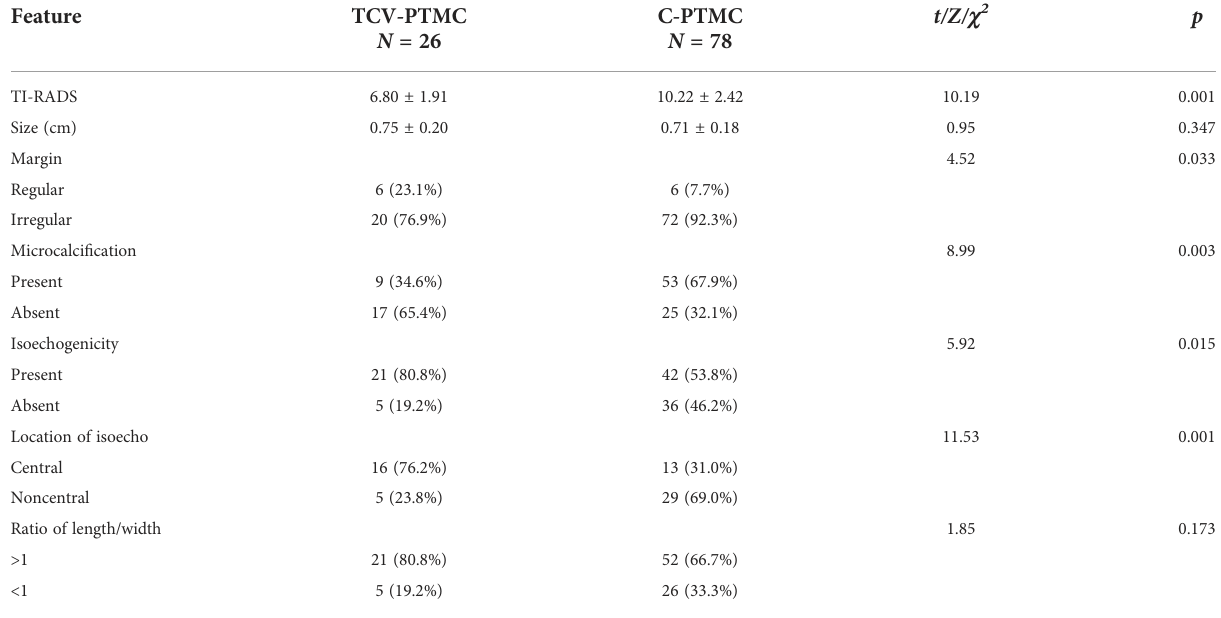
TABLE 2 Ultrasonic characteristics of TCV-PTMC and C-PTMC